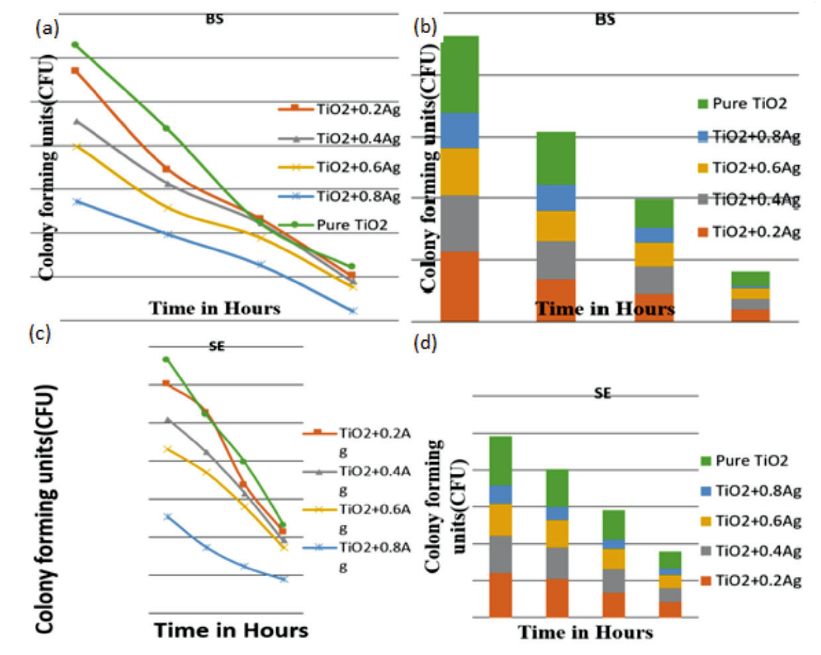
: Ag (a) & (b): Staphylococcus epidermidis ( SE ) for TiO 2